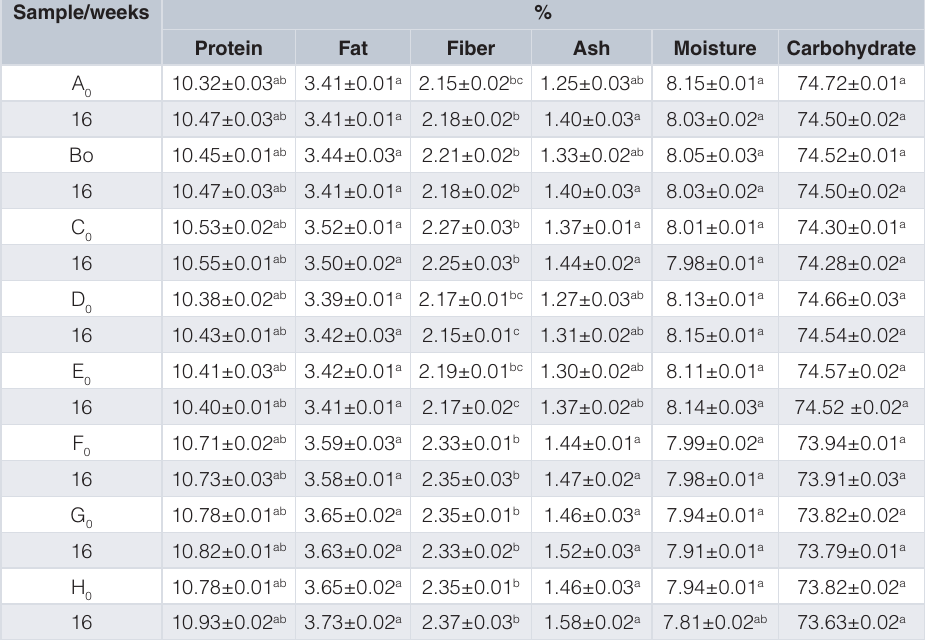
Table 1. Proximate Composition of Ogi (maize) flour with Garlic and Ginger.